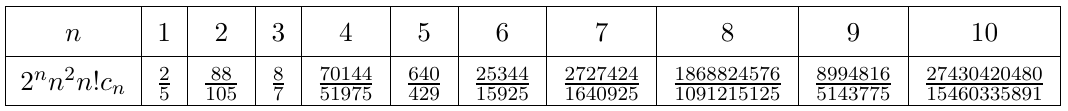
The normalized coe(cid:14)cients of the Taylor series for the function f ( z ), eq. (4.8), up to n =